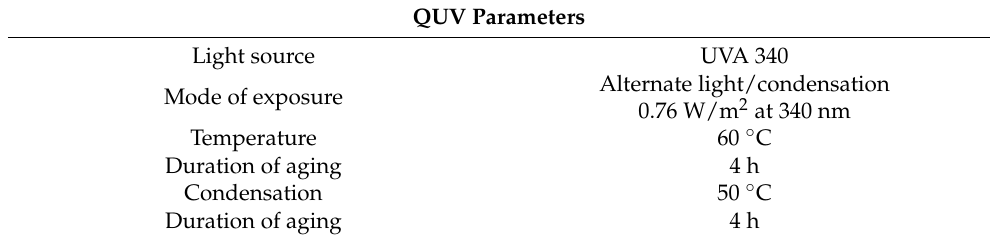
Table 2. Experimental details of the QUV test.